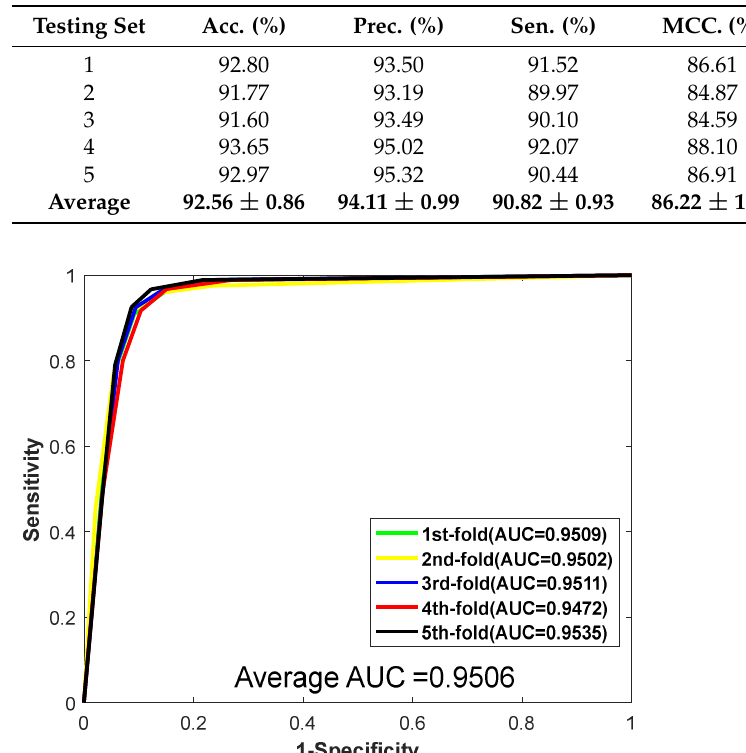
Table 3. Prediction performance of the H. pylori dataset based on five-fold cross-validation method.